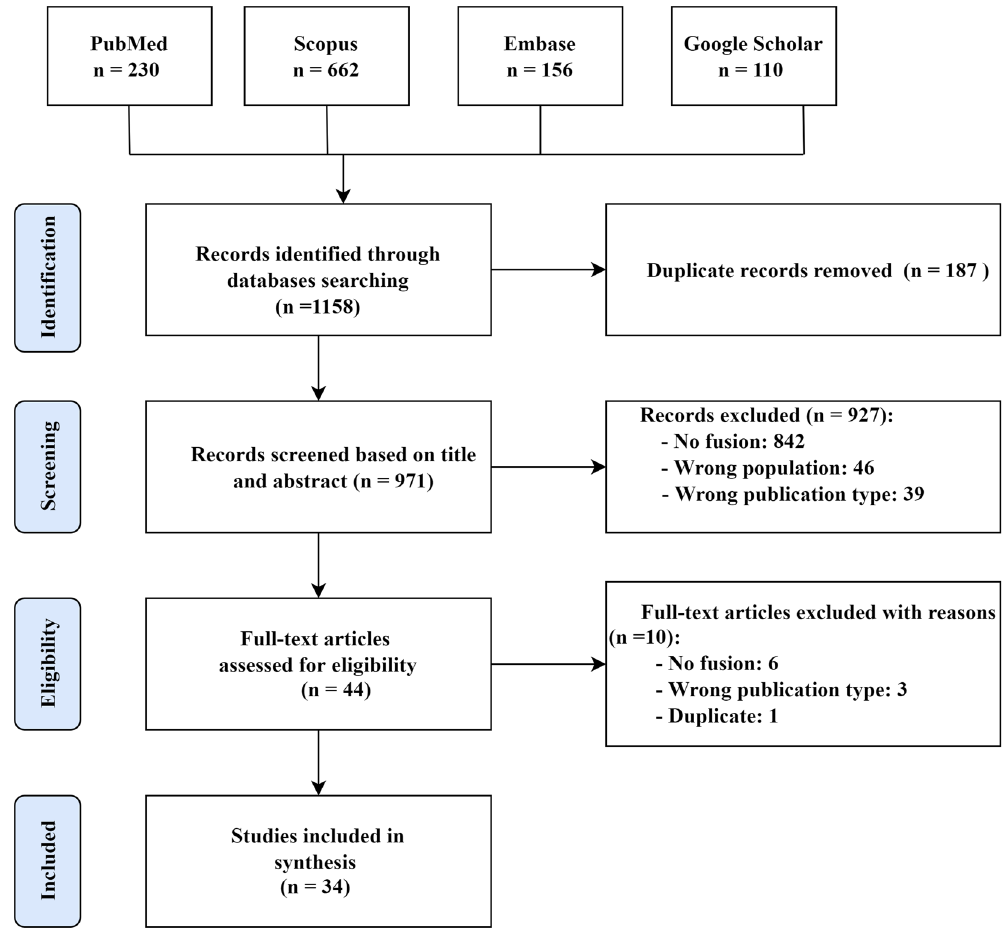
Figure 1. PRISMA flow chart for study identification, screening, and